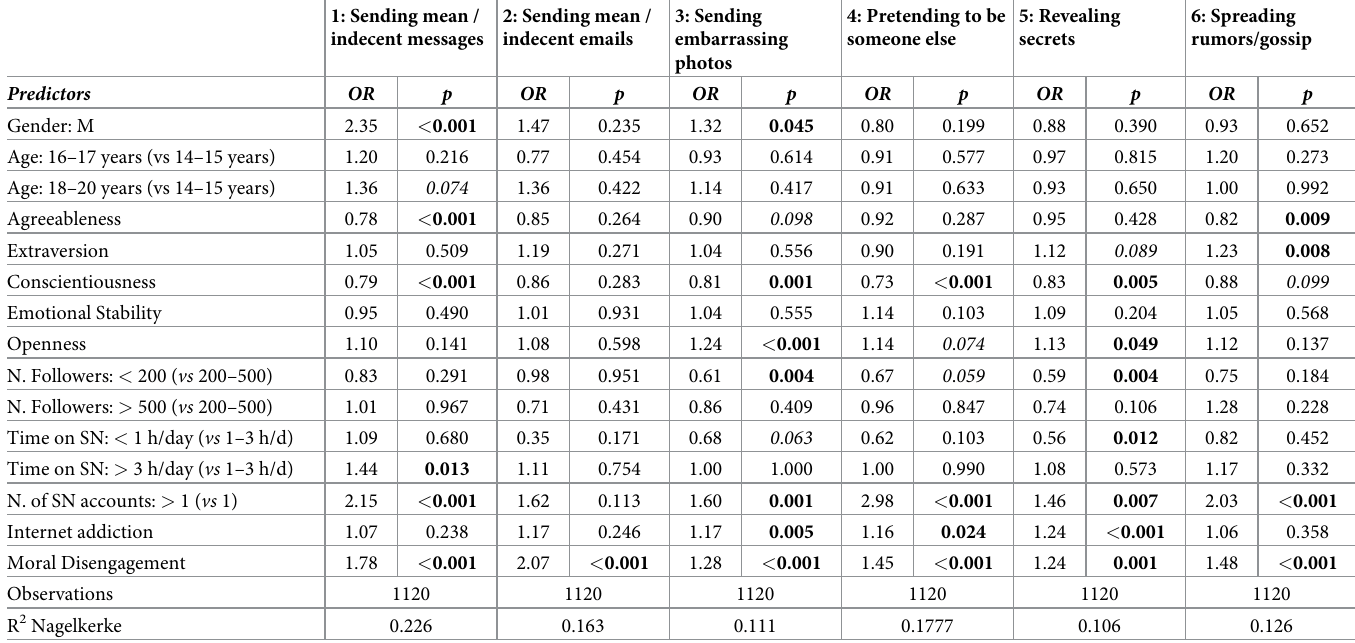
Table 5. Results of the ordinal regressions models for the responses about the frequency of different cyberbullying behaviours.